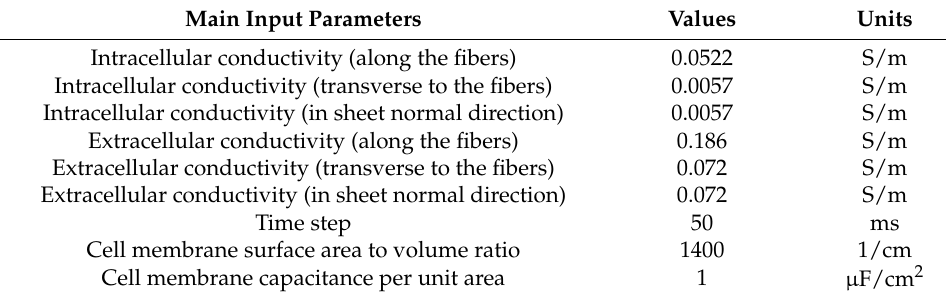
Figure 1. Schematic representation of the pipeline to build the whole ventricular electrophysiological model of myocardial ischemia caused by distal occlusion of left anterior descending branch. Table 1. The main input parameters of the whole ventricular electrophysiological